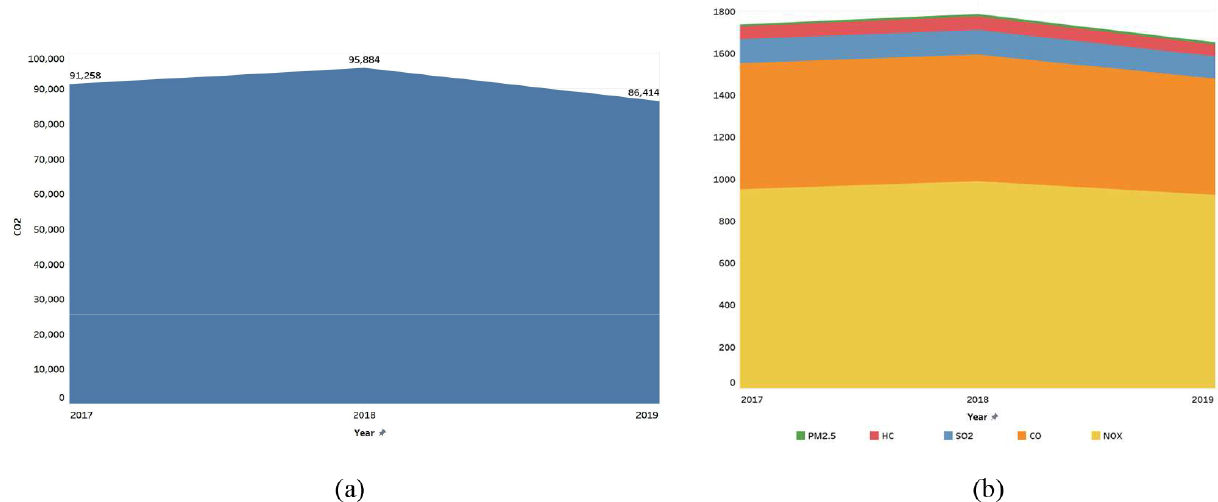
Figure 8. Annual average emissions of six pollutants from routes after the CNG2020 strategy was proposed (tonnes). (a) Average overall route emissions of CO 2 from 2017 to 2019. (b) Average overall route emissions of the other five pollutants from 2017 to 2019.